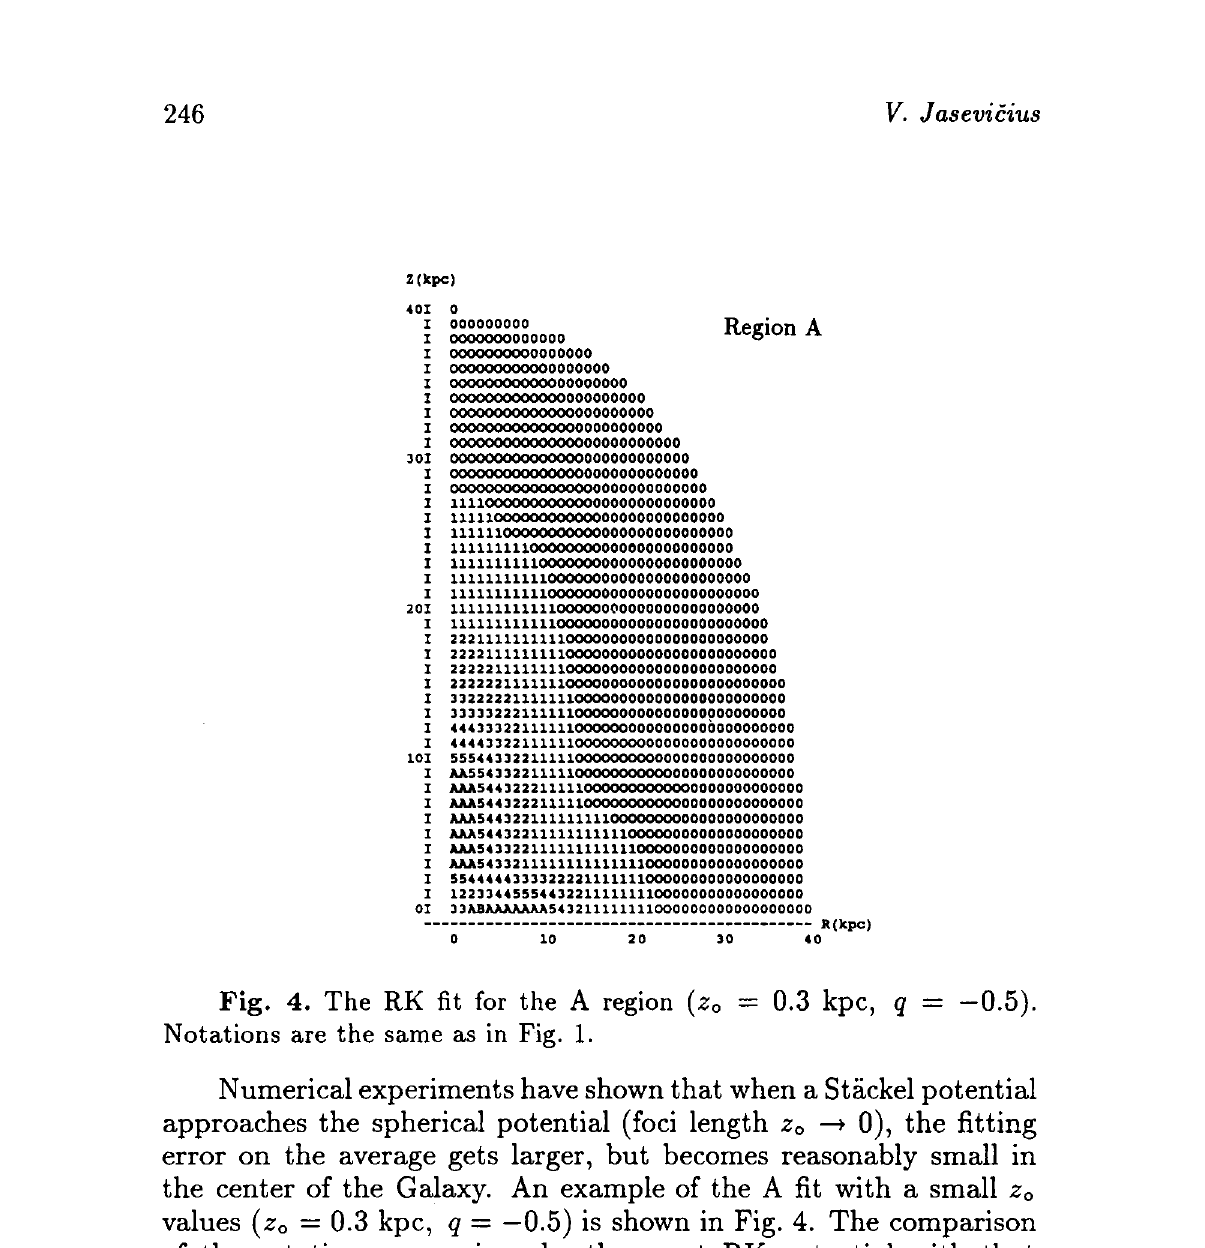
Fig. 4. The RK fit for the A region (z 0 = 0.3 kpc, q =